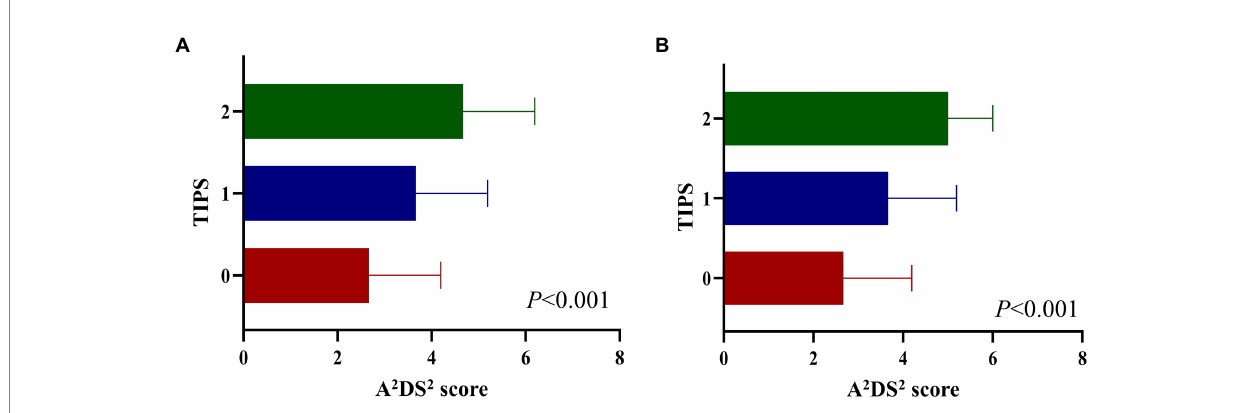
FIGURE 1 A 2 DS 2 score in different TIPS scores in the derivation set (A) , and validation set (B) . A 2 DS 2 , National Institutes of Health Stroke Scale; TIPS, the thrombo- inflammatory prognostic score.